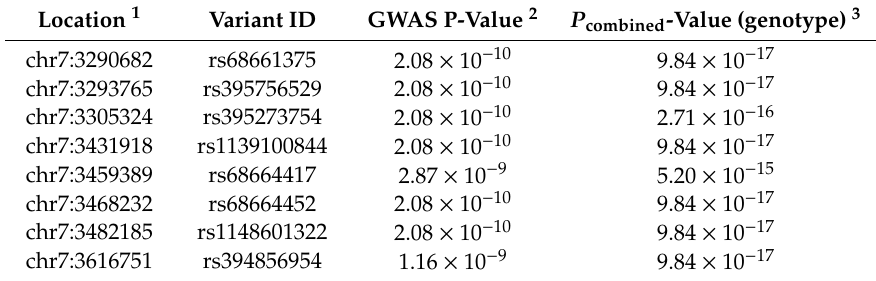
Figure 2. A genome wide association study (GWAS) identifies the locus for mushroom phenotype in Shetland Ponies. ( A ) Manhattan Plot for the χ 2 basic allelic association test. ( B ) Single locus mixed linear model (SLMM) utilizing an F-test to calculate p-values. ( A , B ) Plotted on the y-axis are the -log 10P values calculated for each test against the chromosomes plotted on the x-axis. The horizontal black line across each plot represents Bonferroni significance ( P < 1.4 × 10 − 7 ). ( C ) A 326 kb region on ECA7 reaching genome wide significance. Plotted in blue are the data points from the SLMM GWAS analysis ( N = 24). Plotted in green are the eight SNPs from this region genotyped in our replication sample set, displaying the combined p-values under a recessive model for the GWAS and replication sample sets ( N = 40 mushroom ponies, N = 29 chestnut). Table 1. Eight SNPs reaching genome wide significance and spanning the 326 kb mushroom associated haplotype.